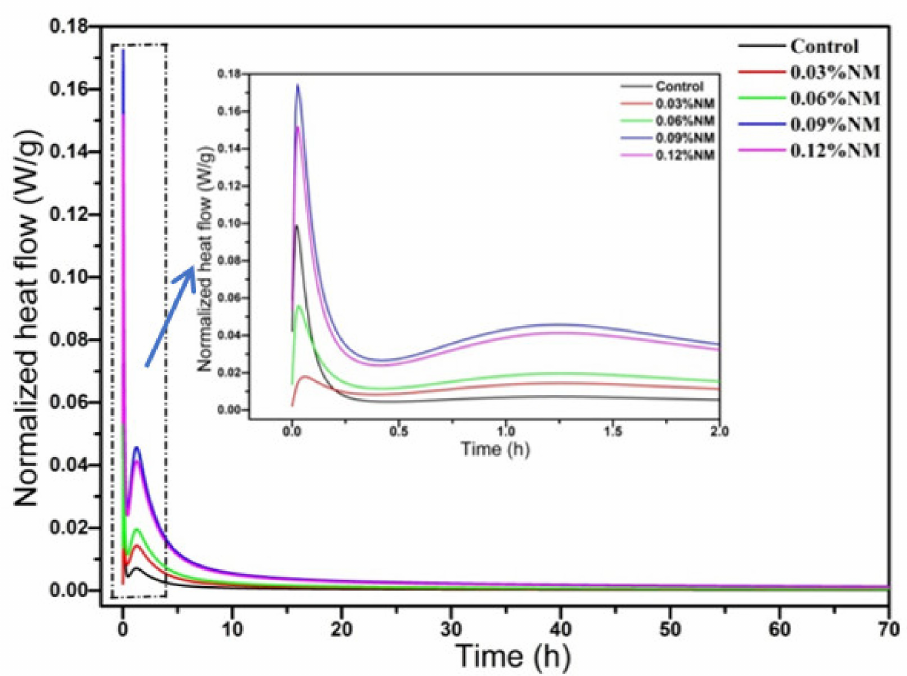
Figure 3. Effect of GO on heat